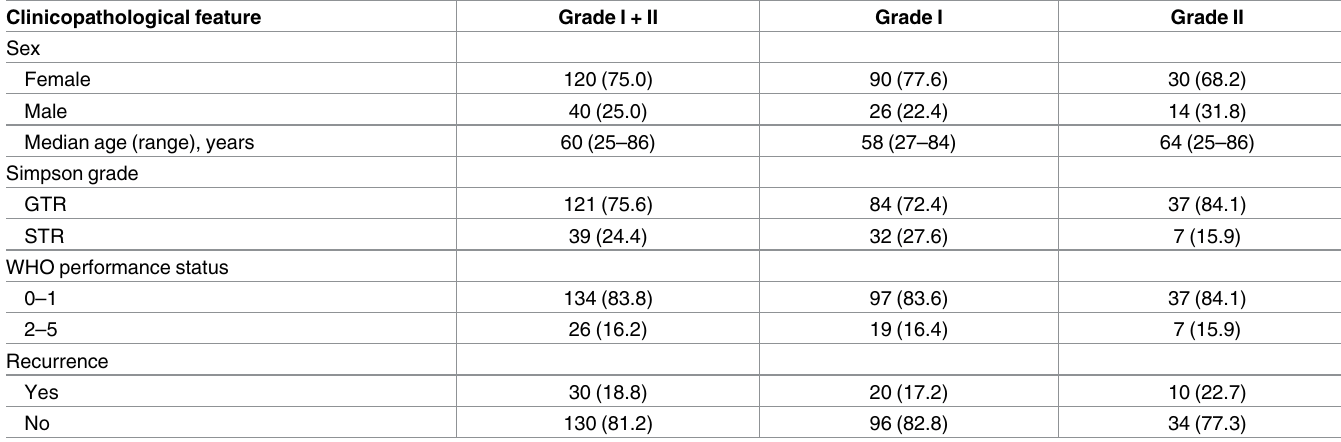
Table 1. Clinical data according to 2016 WHO histopathological grade.